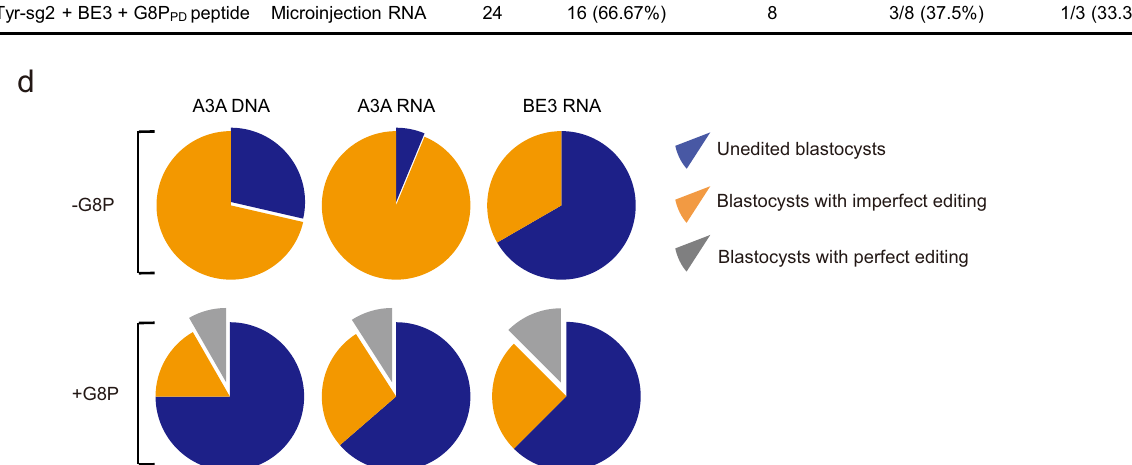
Fig. 5 Co-injection of G8P PD mRNA or peptide facilitates precision base editing of mouse embryos using CBE-coding plasmids or mRNAs. a Design of sgRNA targeting to mouse Tyr gene for introduction of stop codon. The PAM sequence and targeted cytidine are shown in blue and red, respectively. b Schematic presentation showing experimental procedures. c The outcome of base editing in mouse embryos in the absence and presence of G8P PD . d Analysis of CBE-induced mutations in ampli fi ed gene alleles of blastocysts. Source data are provided as a Source Data fi